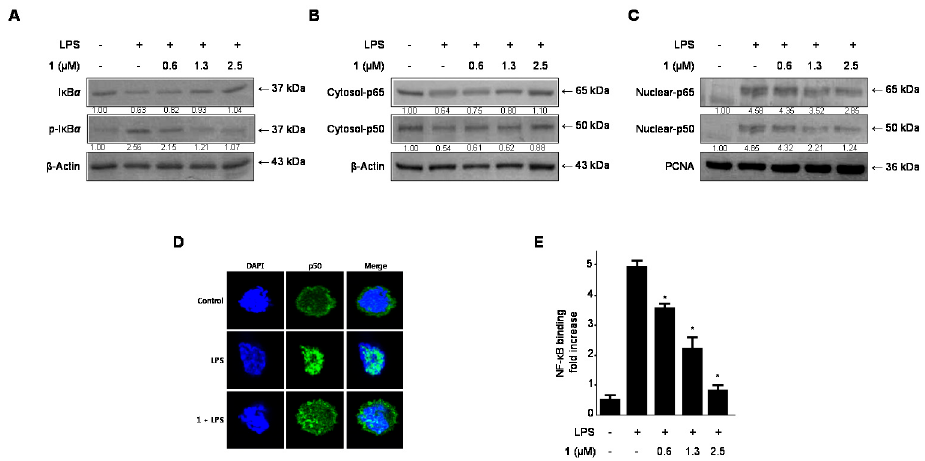
Figure 5. The effects of cudratricusxanthone A ( 1 ) on I κ B- α phosphorylation and degradation ( A ); NF- κ B translocation ( B , C ); NF- κ B localization as determined by immunofluorescence analysis ( D ); and NF- κ B DNA binding activity ( E ) in BV2 microglia. Cells were pretreated for 3 h with the indicated concentrations of cudratricusxanthone A ( 1 ), and stimulated for 1 h with LPS (1 µg/mL). The LPS treatment was performed in the presence of compound. Western blot analyses of I κ B- α and p -I κ B- α in the cytoplasm ( A ) and NF- κ B in the cytoplasm ( B ) and nucleus ( C ) and immunofluorescence analyses ( E ) were carried out as described in the Experimental Section. The band intensity was quantified by densitometry and normalized to β -actin and PCNA, and the values are presented at the bottom of the each band. Relative data represent the means ± SDs of three experiments. * p < 0.05 compared with the LPS-treated group. “+” is treated, “ − “ is not treated.